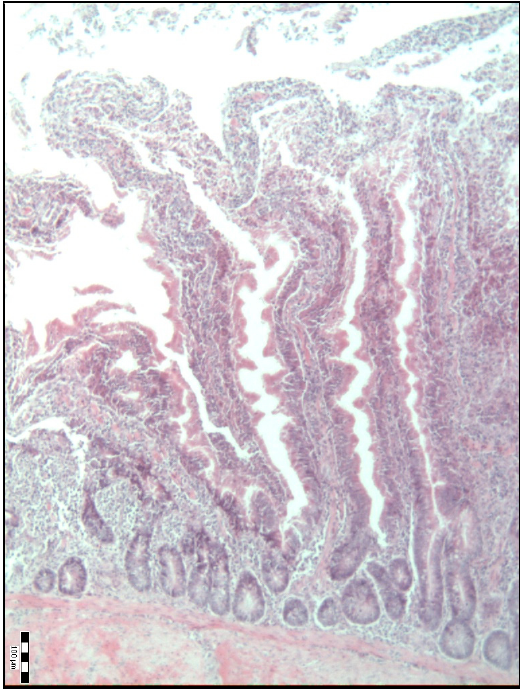
Figure 1. Histological representation of the duodenal villi of broiler chickens from the control group of chickens (K) (H&E; ×100).